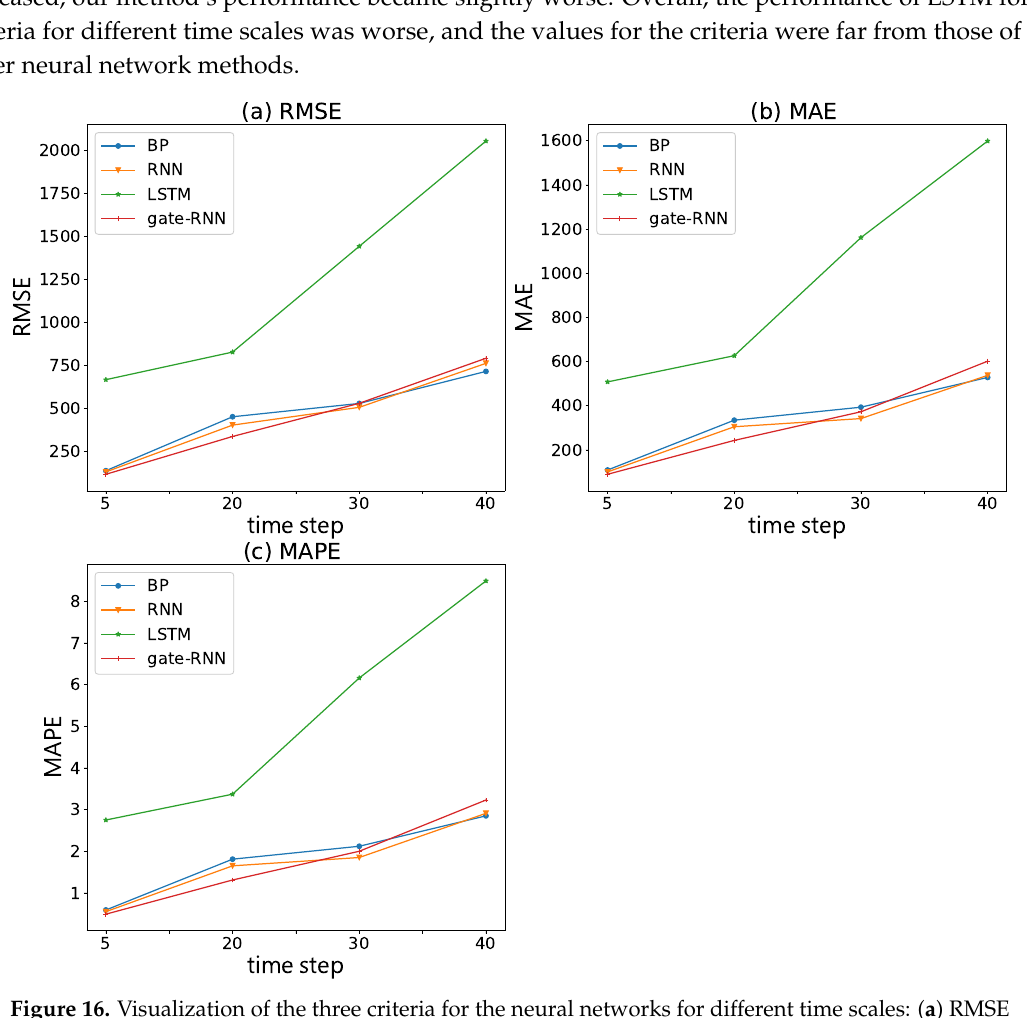
Figure 16. Visualization of the three criteria for the neural networks for different time scales: ( a ) RMSE of the neural networks for different time scales; ( b ) MAE of the neural networks for different time scales; and ( c ) MAPE of the neural networks for different time